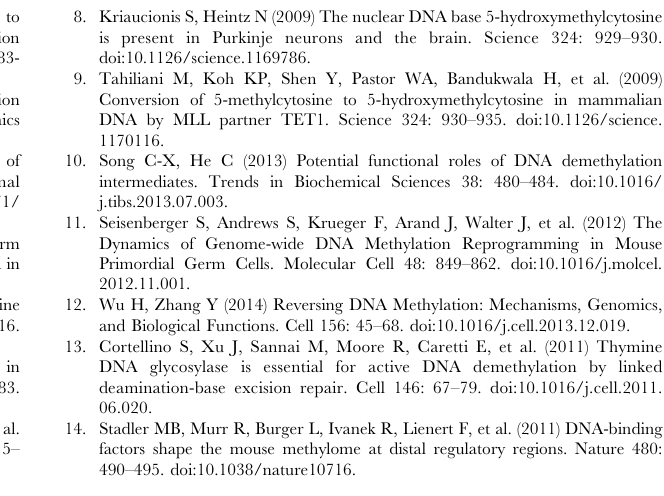
Table S1 Matching criteria and ranges for matched pairs analyses. Table S2 List of cancer samples classified by cancer subtype. Table S3 Correlations between the expression of mismatch repair, base excision repair and Tet genes and C to G transversion rates across 346 cancer genomes. Table S4 ENCODE data used to genotype H1